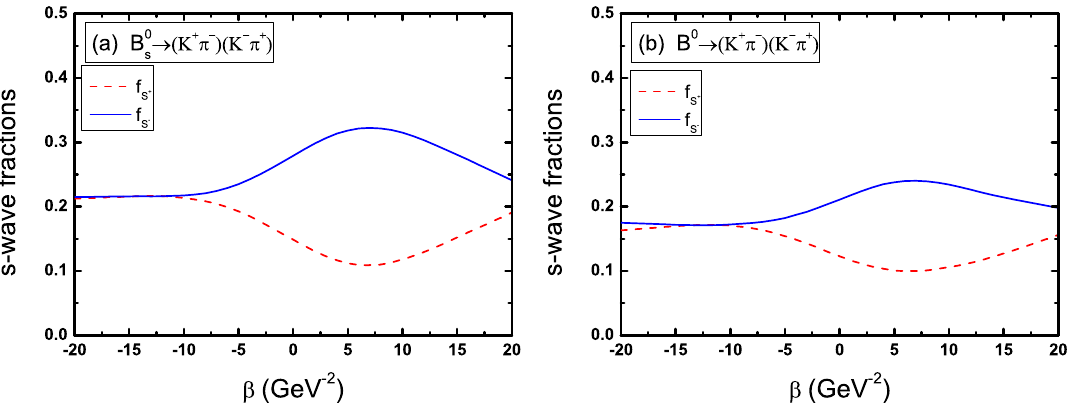
Figure 3 . Dependencies of the S -wave fractions f (dashed red curve) and f (solid blue curve) S + S − on the parameter β in the modes (a) B 0 → ( K + π − )( K − π + ) and (b) B 0 → ( K + π − )( K − π + ) . s between the S - and P -wave configurations. Therefore, the phenomenological parameter β introduced in eq. (2.31) affects the relative strength of f and f . Figure 3 illustrates S − S + the influence of β on the two single S -wave fractions, where the dashed red and solid blue curves describe f and f , respectively. It is found that the S -wave fractions are more S − S + sensitive to β in the region of [-5,20] GeV − 2 . The value of β can be bounded in the range β = (7 . 5 ± 2 . 5) GeV − 2 , in which f and f have reasonable relative magnitudes to S − S +